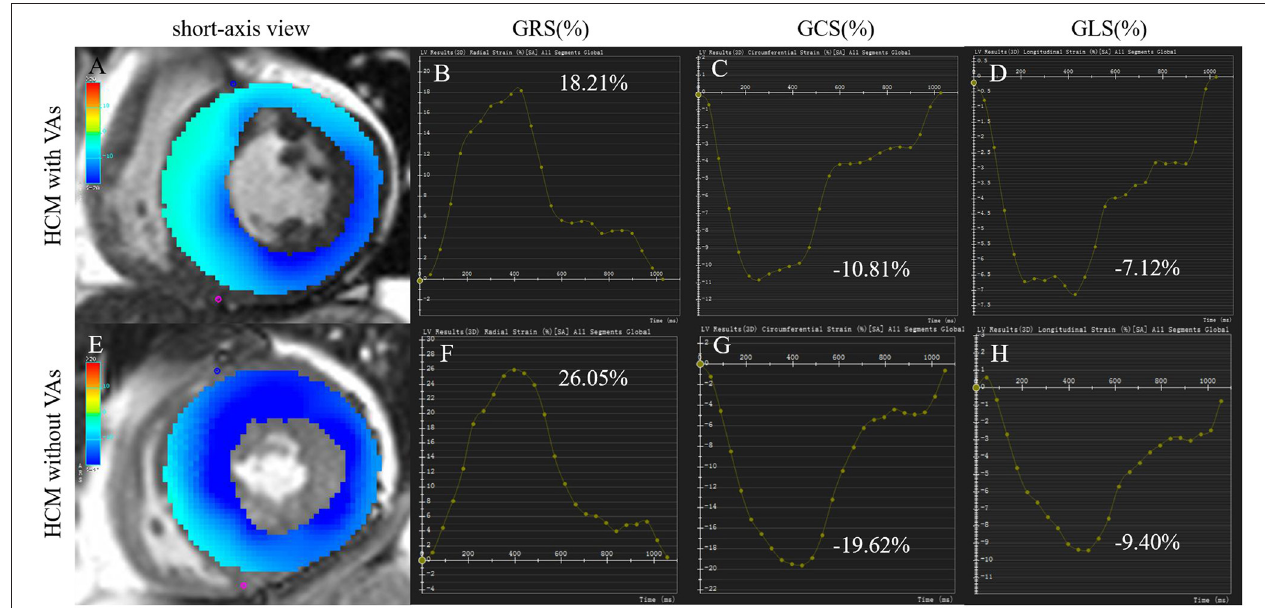
FIGURE 2 | Tissue tracking and strain analysis in HCM with and without VAs. Left column (A,E) : color overlap map of short-axis view. Right columns (B–D, F–H) : strain analysis curves of GRS, GCS, and GLS. The myocardial strain parameters in a 55-year-old man with VAs (A–D) were much lower than those in a 74-year-old woman without VAs (E–H) . GCS, global circumferential strain; GLS, global longitudinal strain; GRS, global radial strain; HCM, hypertrophic cardiomyopathy; VA, ventricular